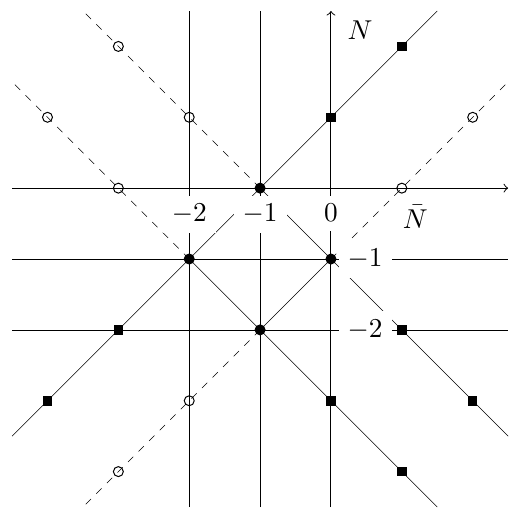
Figure 5 . This picture represents a solution to consistency conditions (2.25), (2.26). The solution consists of weights, which are indicated by solid circles and solid squares. Non-vanishing F and G are represented by solid lines joining pairs of points. More precisely, non-vanishing F ( N, ¯ N ) is indicated by a line joining ( N, ¯ N ) and ( N + 1 , ¯ N + 1) , while non-vanishing G ( N, ¯ N ) is denoted by a line that connects ( N, ¯ N ) and ( N + 1 , ¯ N − 1) . The non-vanishing coefficients are constrained by F ( − 1 , − 2) + G ( − 1 , 0) = − 1 /R 2 , F ( − 2 , − 1) = F ( − 1 , − 2) and G ( − 2 , − 1) = G ( − 1 , 0) . The remaining non-vanishing F and G are equal to − 1 /R 2 . There are also other solutions of a similar type. These can be obtained from the one above as follows. On the picture, there is a semi-infinite line of weights represented by solid squares, with the end-point at ( N, ¯ N ) = ( − 1 , 0) . These weights can be replaced with those represented by empty circles and forming a line that also ends at ( − 1 , 0) . Alternatively, this can be described as the reflection of the weight space with respect to N = − 1